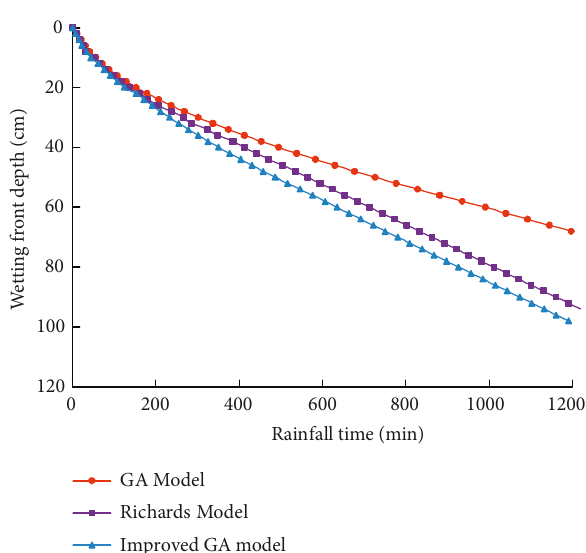
Figure 10: Calculation model.